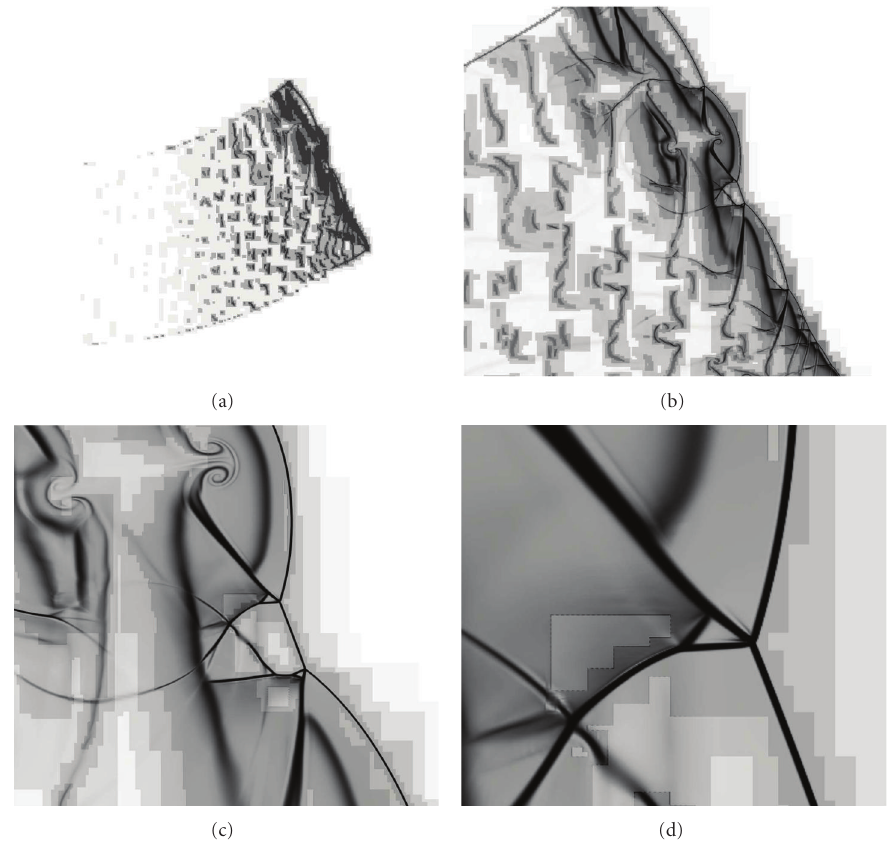
Figure 22: Successively enlarged schlieren plots of the density on refinement regions at t = 150 μ s for the detonation propagating through the pipe bend. The simulation resolves the detailed structure around each triple point, cf. Figure